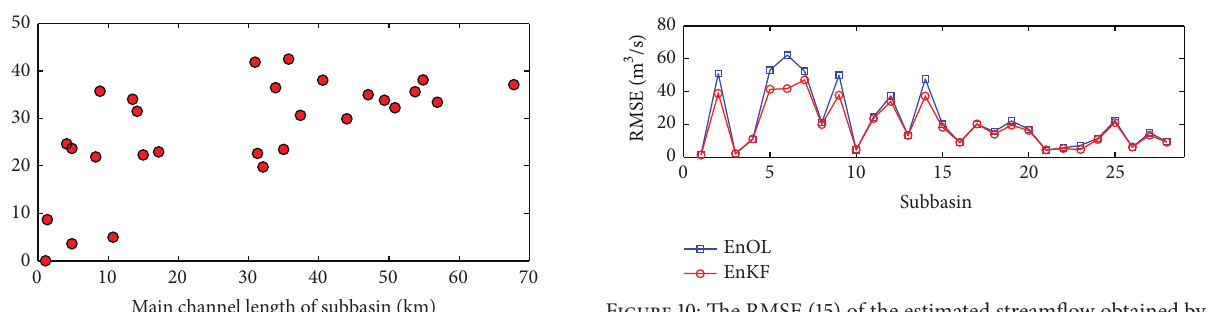
Figure 8: Comparison of the RMSE (15) for the estimated surface runoff storage ( 𝑄 slope steepness, (b) soil category, and (c) land cover. S-1, S-2, S-3, S-4, S-5, S-6, and S-7 are the seven types of soil (Table 1). RICE, AGRC, FRST, SESB, and MESQ represent the land cover of rice, mixed agriculture, mixed forest, the Sesbania , and honey mesquite, respectively. The solid black line is the 1: 1 line.